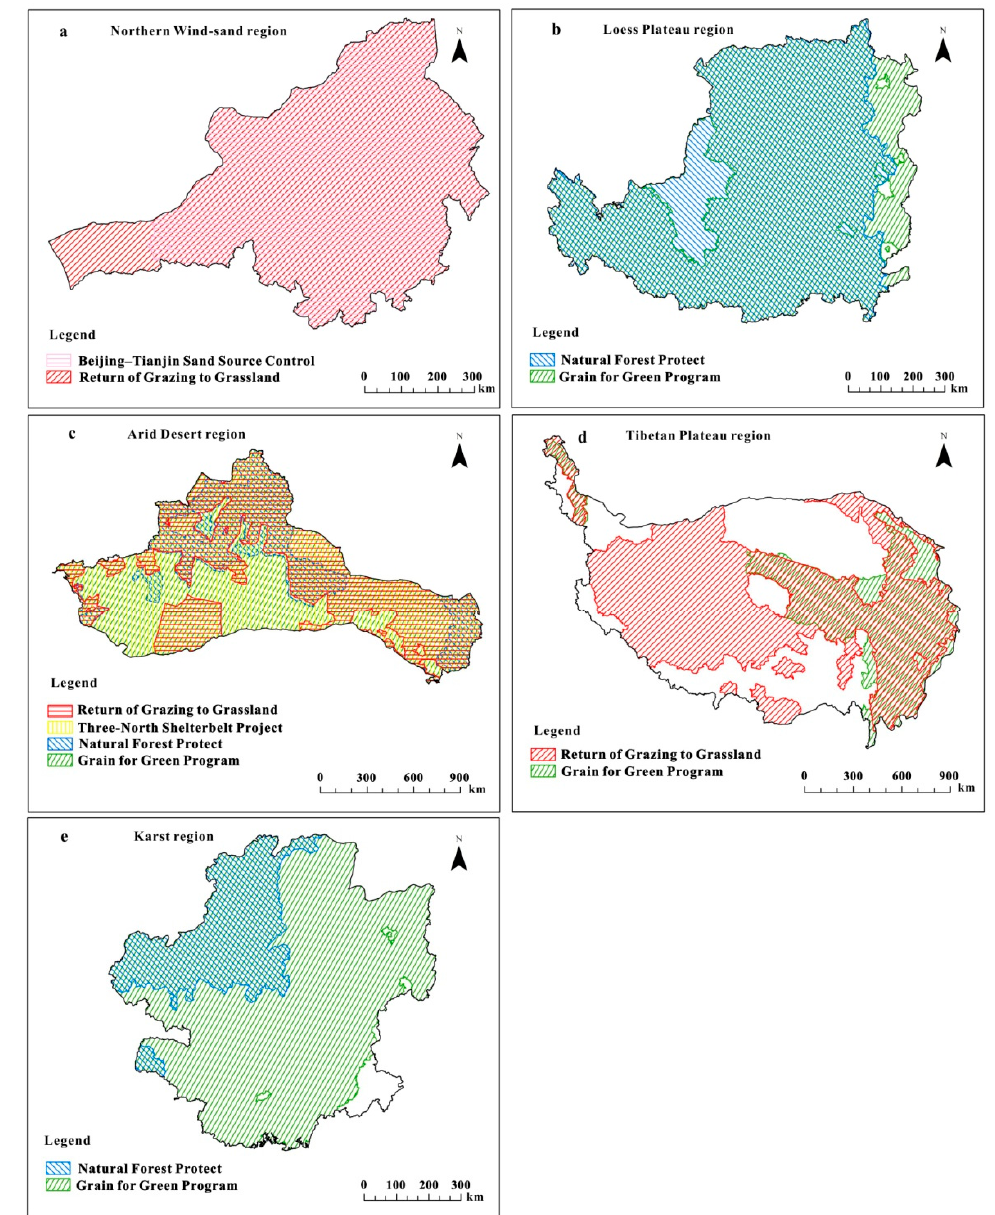
Figure 7. Major ecological programs in the Northern Wind-sand region ( a ), Loess Plateau region ( b ), Arid Desert region ( c ), Tibetan Plateau region ( d ), and Karst region ( e ).